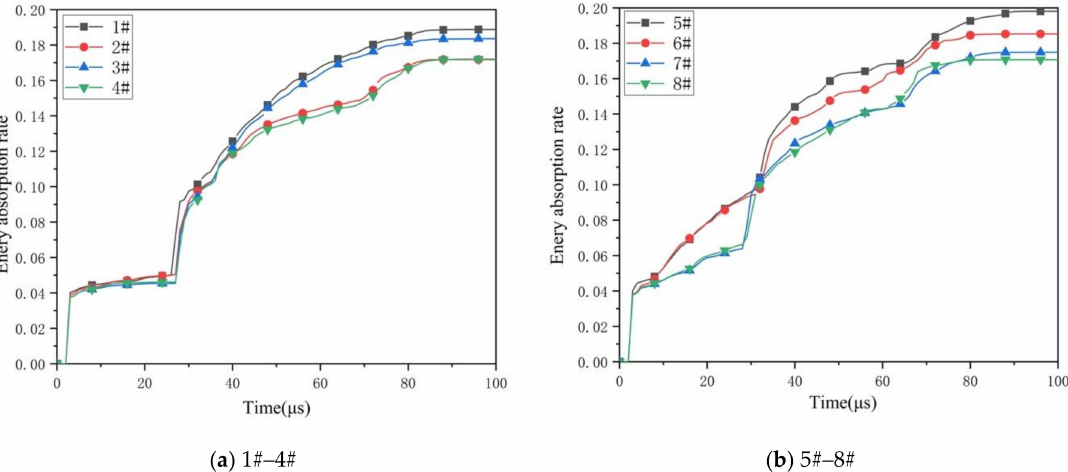
Figure 7. Energy absorption rate curves. ( a ) Energy absorption rate curves of 1#–4#; ( b ) Energy absorption rate curves of